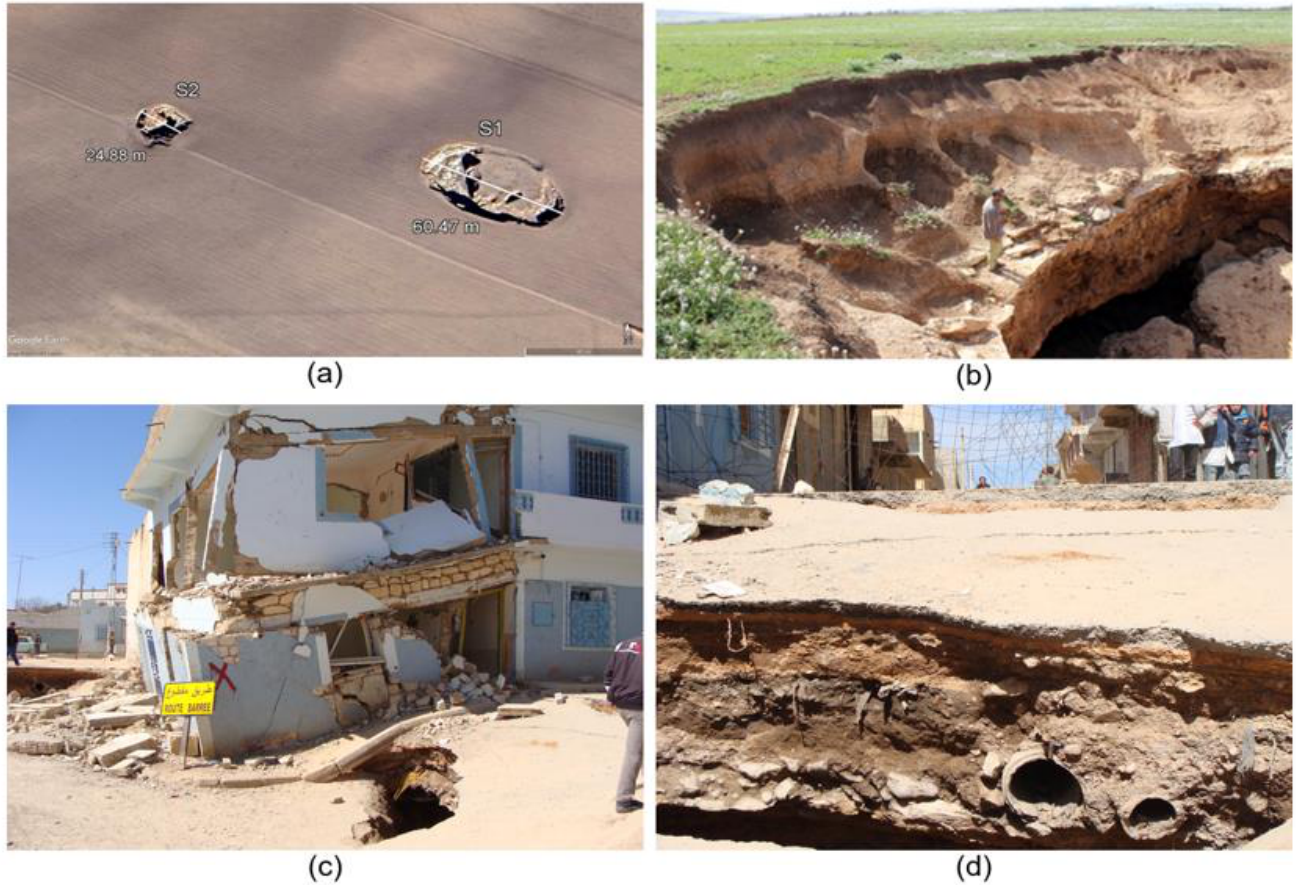
Figure 3. Sinkhole example images: ( a ) Draa-Douamis sinkholes 1 and 2 collapsed with a diameter of 66.47 and 24.88 m, respectively (location: see Figure 1—sinkhole sites; date: during 2004); ( b ) example of sinkhole diameter enlargement in surface; ( c ) Harkat Bouziane sinkhole collapsed in the city with a diameter of ~50 m and height of 2 m (location: see Figure 1—sinkhole sites; date: February 2009), destroying infrastructure; and ( d ) damage created by a sinkhole event (i.e., sewer network and roads broken).